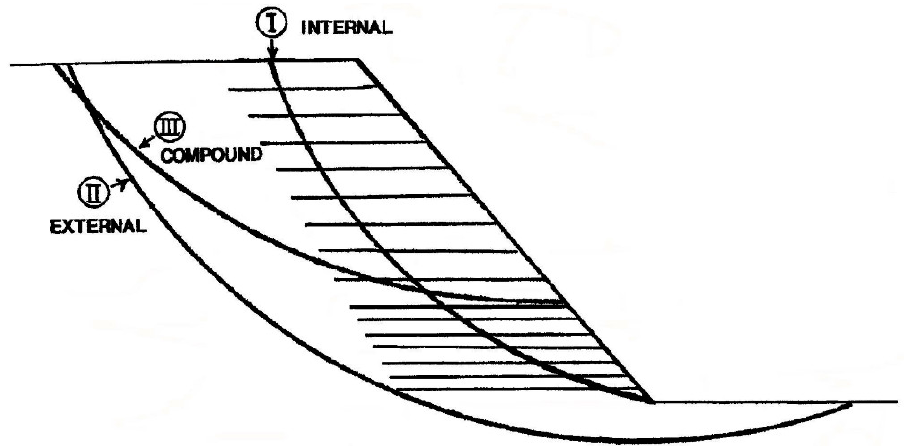
Figure 1. Failure modes of reinforced slopes [2].